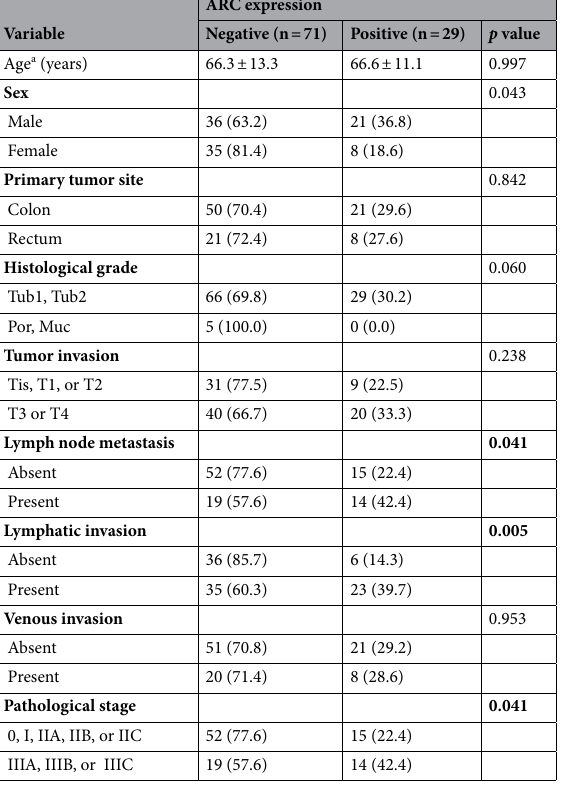
Table 1. Relationship between ARC expression and patient characteristics. Tub1, well-differentiated adenocarcinoma; Tub2, moderately differentiated adenocarcinoma; Por, poorly differentiated adenocarcinoma; Muc, mucinous adenocarcinoma. Bold values indicate p < 0.05. a Continuous variable.